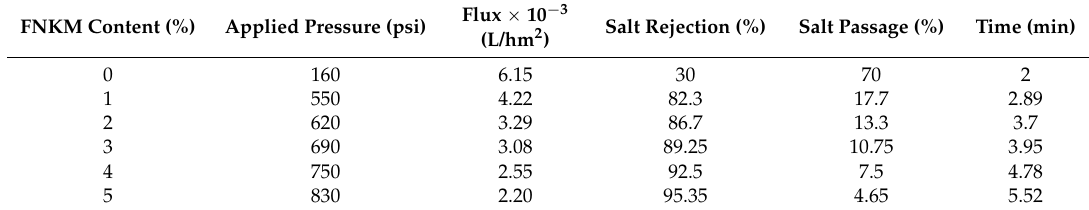
Figure 10. Correlation between FNKM loading content and time taken to collect 100mL permeate. 3. Experimentation